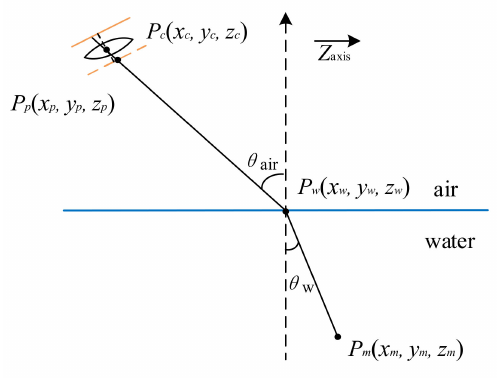
Figure 1. Refraction